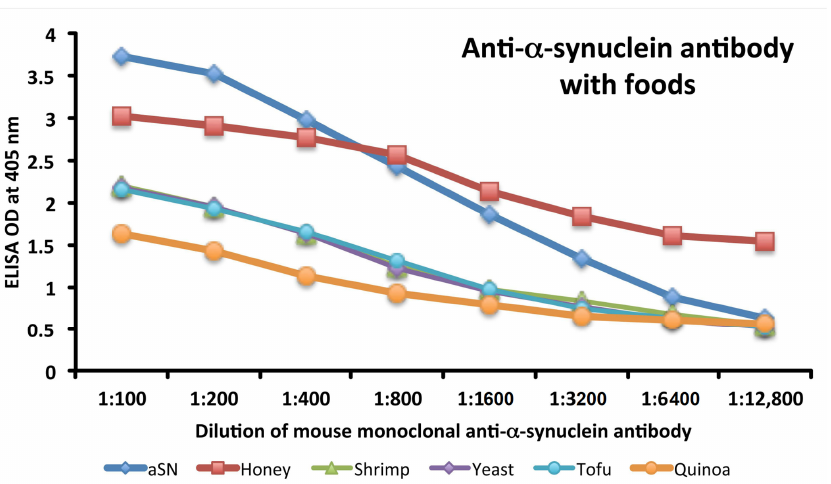
Figure 3. Analytical specificity by serial dilution study for mouse monoclonal anti-aSN. Shown are the reactions of various dilutions of mouse monoclonal anti-aSN antibody with alpha-synuclein (blue diamond), honey (red square), shrimp (green triangle), yeast (purple diamond), tofu (light blue circle) and quinoa (orange circle).